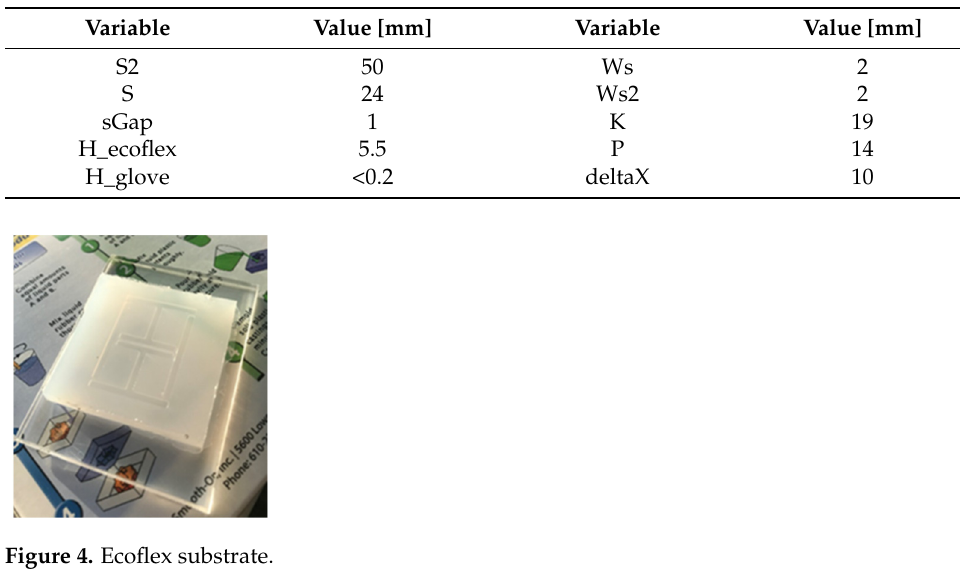
Figure 6. Finished Ecoflex tag with conductive ink.